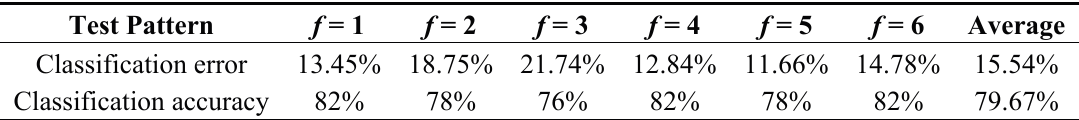
Table 5. Classification accuracy of classifier based on current signal.